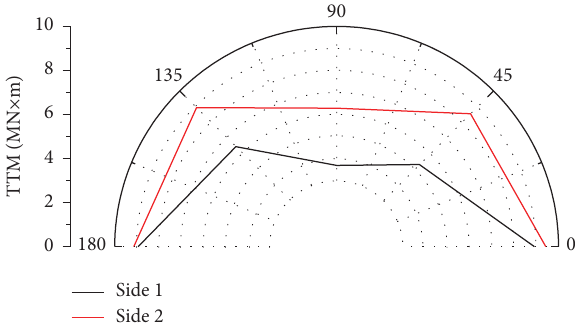
Figure 36: Transverse torsional moment in different